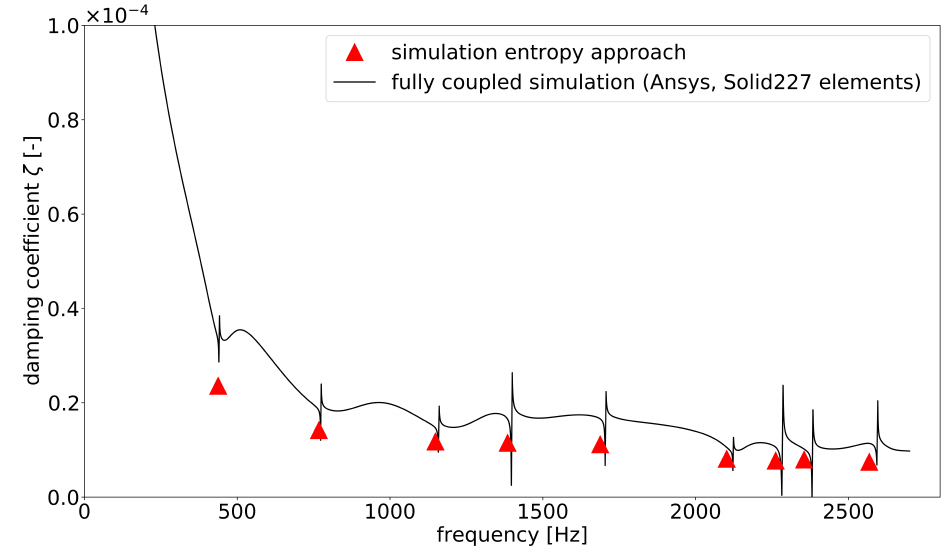
Figure 9. Comparison of the damping coefficients of the modal based entropy approach with the fully coupled thermoelastic ANSYS simulation for the box component.